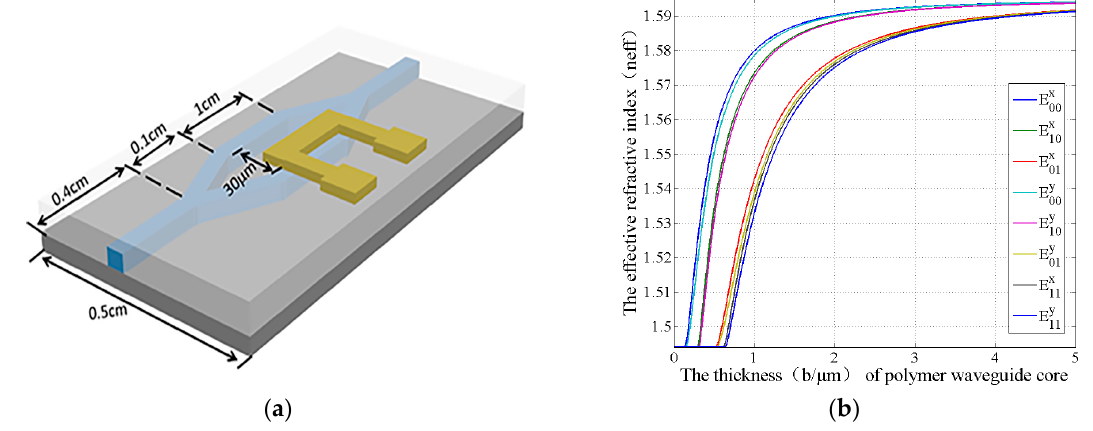
Figure 1. ( a ) The schematic of polymer/silica hybrid thermal optical switch. ( b ) The single mode condition of the polymer waveguide at 532 nm (The aspect ratio is 0.333).